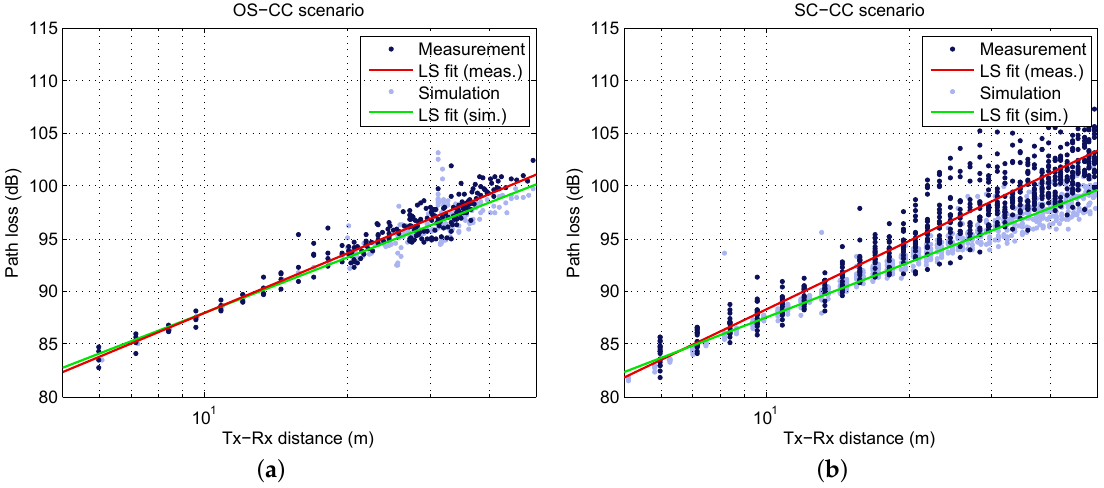
Figure 4. Measured and simulated path loss (PL) versus distance with linear regression line; ( a ) OS-CC scenario; ( b ) SC-CC